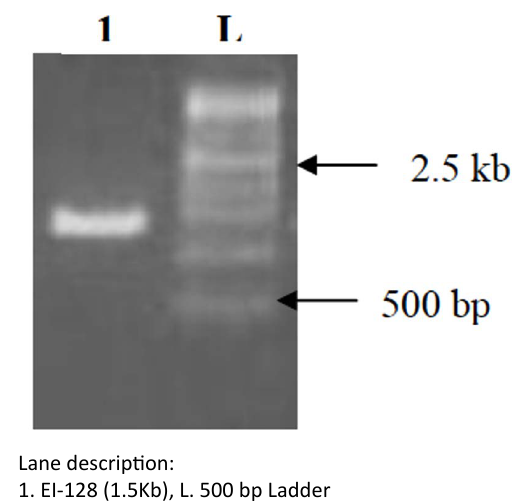
Fig. 3. 16s rDNA fragment from bacterial sample EI-136 Fig. 4. 16s rDNA fragment from Bacterial sample EI-128 on 1% Agarose